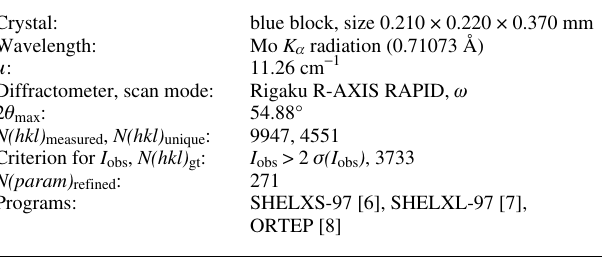
Table 1. Data collection and handling.